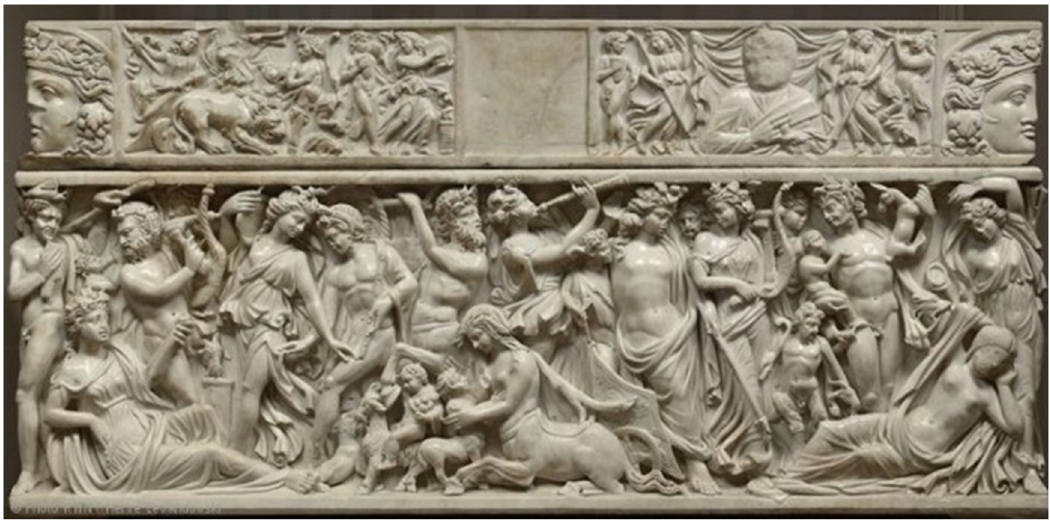
Figure 29: Bacchus and Ariadne. Sarcophagus, 235, CE. Louvre, Paris, France.